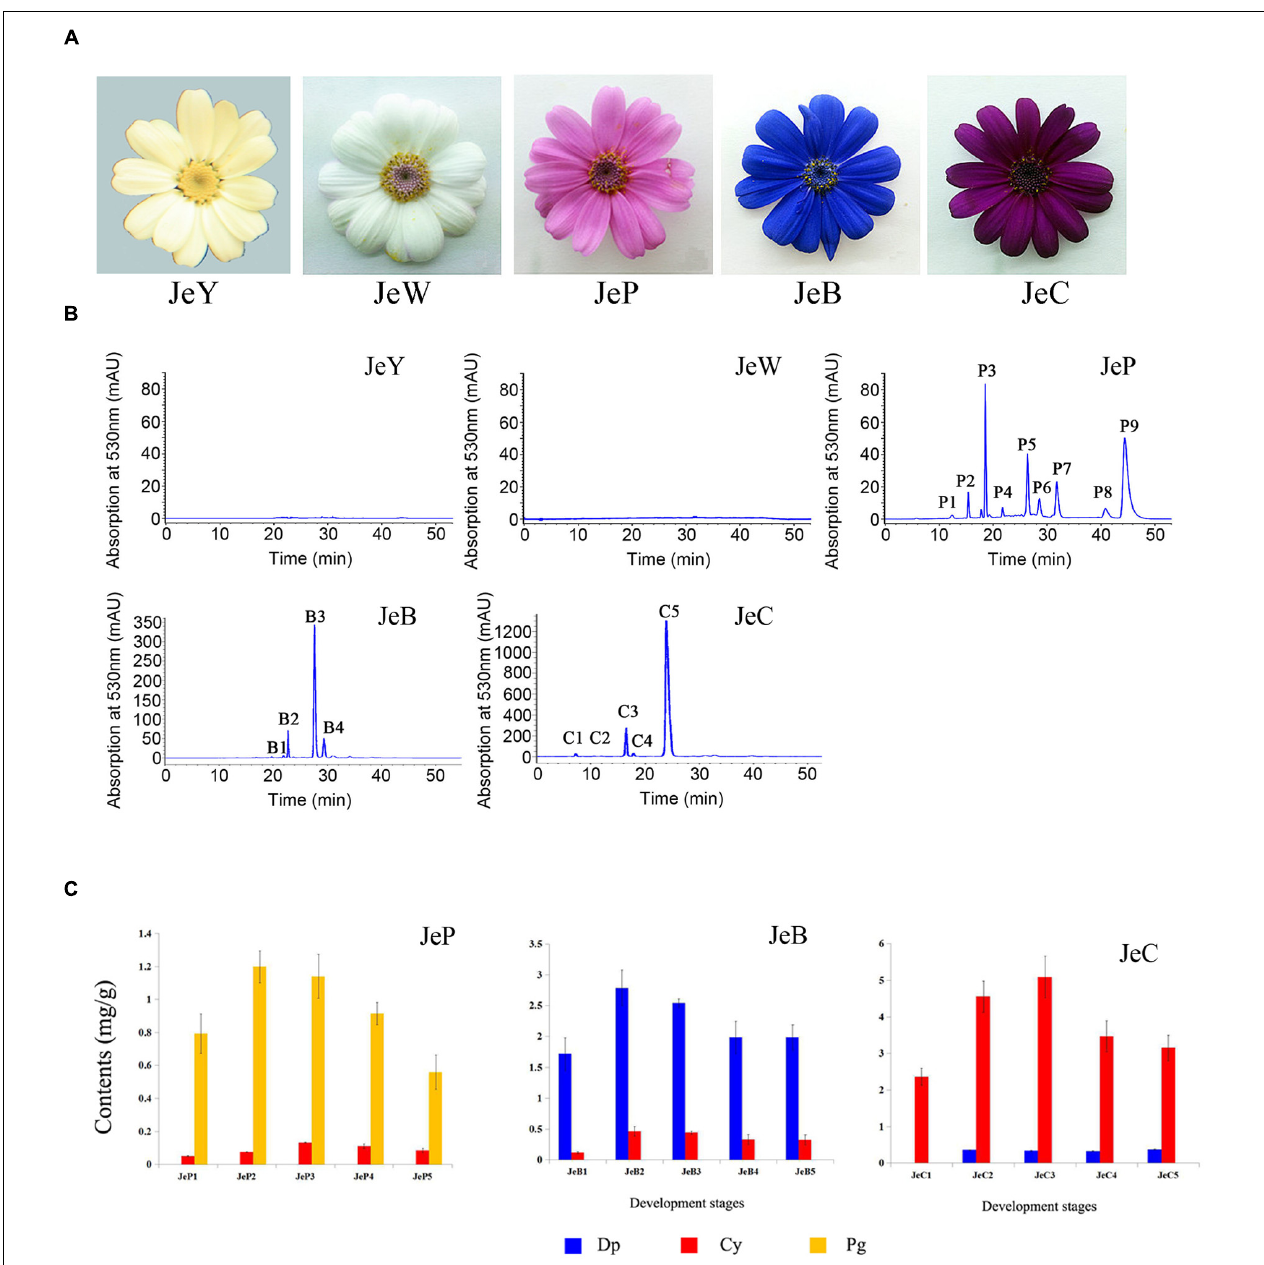
FIGURE 1 | Senecio cruentus cultivars used in this study. (A) JeY, JeW, JeP, JeB, and JeC. (B) Results of anthocyanins composition in different flower color cineraria cultivars by high performance liquid chromatography (HPLC) analysis. (C) Anthocyanins contents of JeB, JeC, and JeP determined by HPLC analysis.